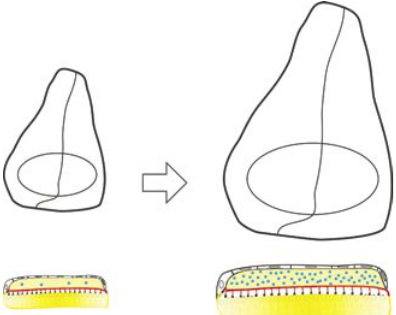
Figure 3. Model for the Coordinated Control of Growth and Patterning in the Drosophila Wing Disc A schematic representation of a growing (left) and a mature (right) wing disc is shown at the top. Corresponding cross-sections through the wing blade region are depicted below. The wing disc originates from the infolding of the embryonic ectoderm and consists of pseudostratified epithelial cells containing a basal–lateral side (yellow) and an apical side (red). The apical surface faces the disc lumen that is formed by the epithelium and the overlaying peripodial membrane (black), consisting of squamous epithelial cells. The morphogen and growth factor Dpp (yellow) is secreted basal–laterally by the Dpp-producing cells located anterior to the anterior–posterior compartment boundary (line through centre of wing disc). The Dpp concentration gradient from the anterior–posterior boundary to the periphery provides the anterior– posterior patterning cues. In addition, Dpp is also secreted apically into the disc lumen where is can diffuse freely. The model proposes that luminal Dpp acts as a growth-promoting factor stimulating disc growth in young discs. As the disc grows, a hypothetical growth inhibitor (blue dots) is also secreted apically and antagonizes the growth promoting activity of Dpp. Once the concentration of the inhibitor has reached a certain threshold, proliferation of wing imaginal disc cells